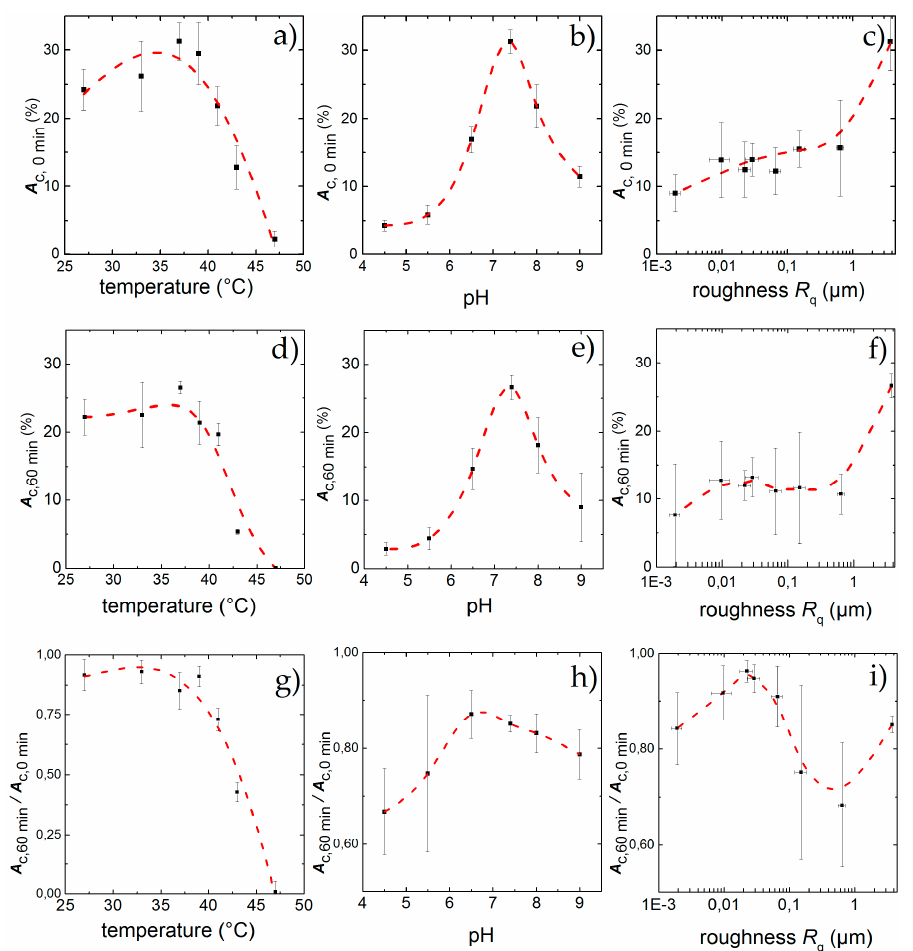
Figure 5. Percentage of area covered with cells after an incubation time of 60 min under standard culture conditions but for different temperatures ( a ), pH ( b ) and surface roughness ( c ); Physiological standard conditions of T = 37 °C and pH = 7.4 show the highest adhesion A c , 0 min while increasing roughness leads to higher A c ,0 min . After applying shear flow for 60 min cell detach leading to a remaining adhesion A c ,60 min for different temperatures ( d ), pH ( e ) and surface roughness ( f ). While the effect of low temperatures hardly effect the cells, high temperatures and deviations from pH = 7.4 lead to strong detachment. For the influence of the topography, a peak in cell adhesion appears for R q = 22 nm, although the highest final adhesion can be found for R q = 3.76 µm. A c ,60 min / A c ,0 min denotes the fraction of the field of view that is covered with cells after 60 min exposure to shear flow. Similar to static conditions, the influence of temperature ( g ), and pH ( h ) inside the physiological range changes A c ,60 min / A c ,0 min only slightly, whereas high temperatures and low pH exhibit a strong effect; A c ,60 min / A c ,0 min as a function of surface roughness ( i ) shows a maximum at R q = 22 nm. The data points and error bars show the mean and standard deviation respectively from n ≥ 5 measurements and the dashed lines are guides to the eye.